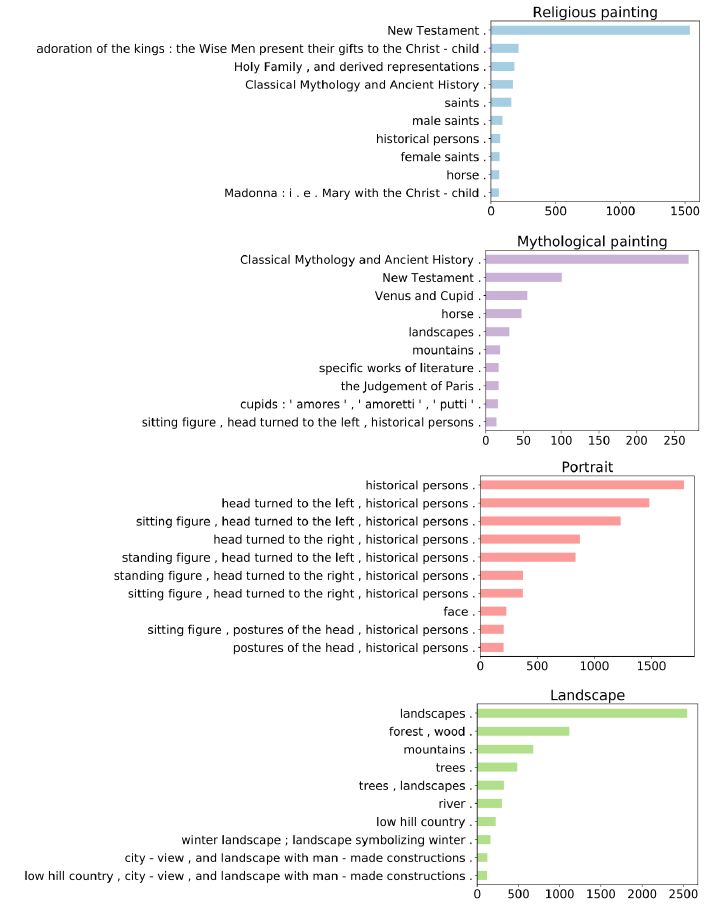
Figure 5. Distribution of most commonly generated captions in relation to four different genres in the WikiArt